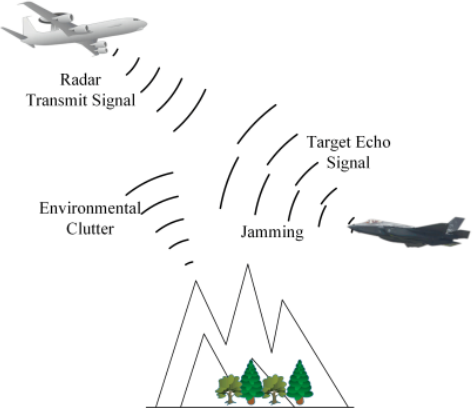
Figure 2. The airborne radar detection scene.